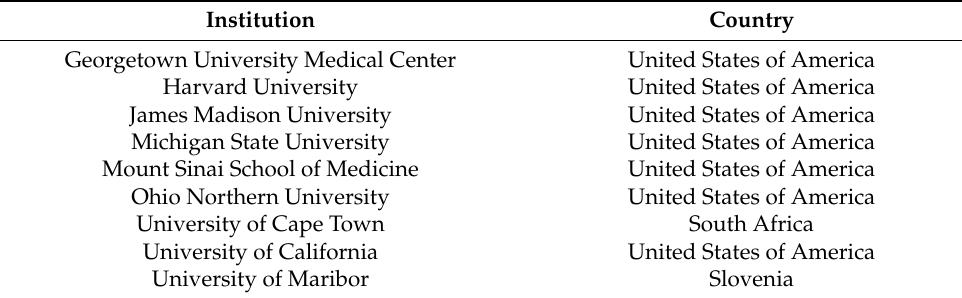
Table 6. Institutions with the highest number of published